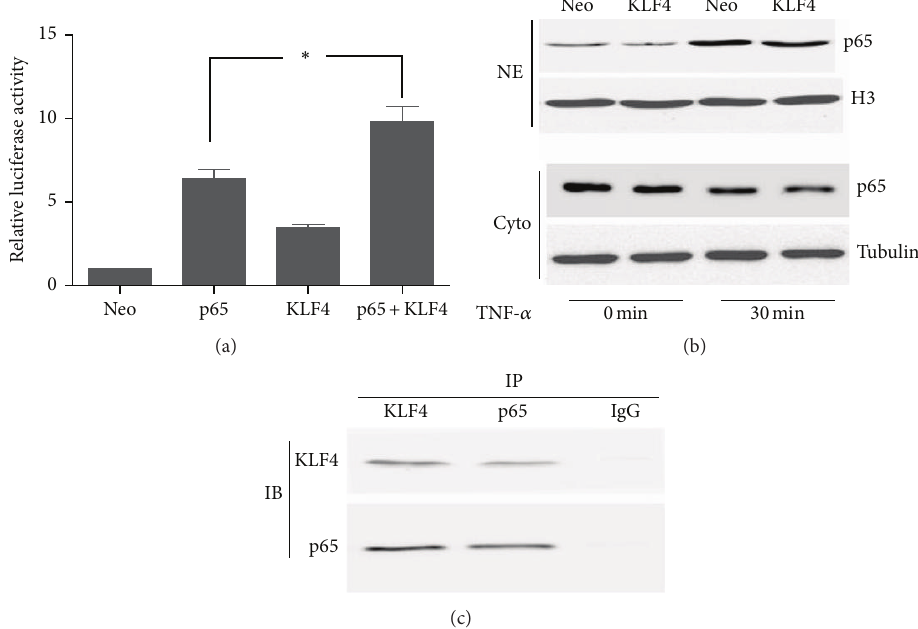
Figure 6: KLF4 and NF- 𝜅 B-p65 cooperatively induce the IL-6 promoter. KLF4 and NF- 𝜅 B-p65 cooperatively induce IL-6 promoter activity. RA FLSs were cotransfected with the indicated IL-6 promoter luciferase plasmids, pcDNA3.1-NF- 𝜅 B-p65 expression plasmid (p65), pcDNA3.1-KLF4 expression plasmid (KLF4), or the pcDNA3.1 empty vector (Neo). IL-6 promoter activity was measured by Dual Luciferase Assay (a). Data were expressed as means ± SEM ( 𝑛 = 3 ). ∗ 𝑃 < 0.05 in comparison to the p65 group. KLF4 does not affect either expression or nuclear translocation of NF- 𝜅 B-p65. RA FLSs were transfected in triplicate with pcDNA3.1-KLF4 expression plasmid (KLF4) or pcDNA3.1 empty vector (Neo) and then incubated with TNF- 𝛼 (20 ng/mL) for 30min. Expression of NF- 𝜅 B-p65 (p65) in the cytoplasm and nucleus was detected by western blot. Cyto: cytoplasmic extracts; NE: nuclear extracts. Histone 3 (H3) and Tubulin served as controls for nuclear and cytoplasmic proteins. KLF4 associates with NF- 𝜅 B-p65. Nuclear extracts from RA FLSs were immunoprecipitated (IP) with anti-KLF4, anti-NF- 𝜅 B-p65 (p65), or anti-IgG antibodies, followed by immunoblotting (IB) with the indicated antibodies